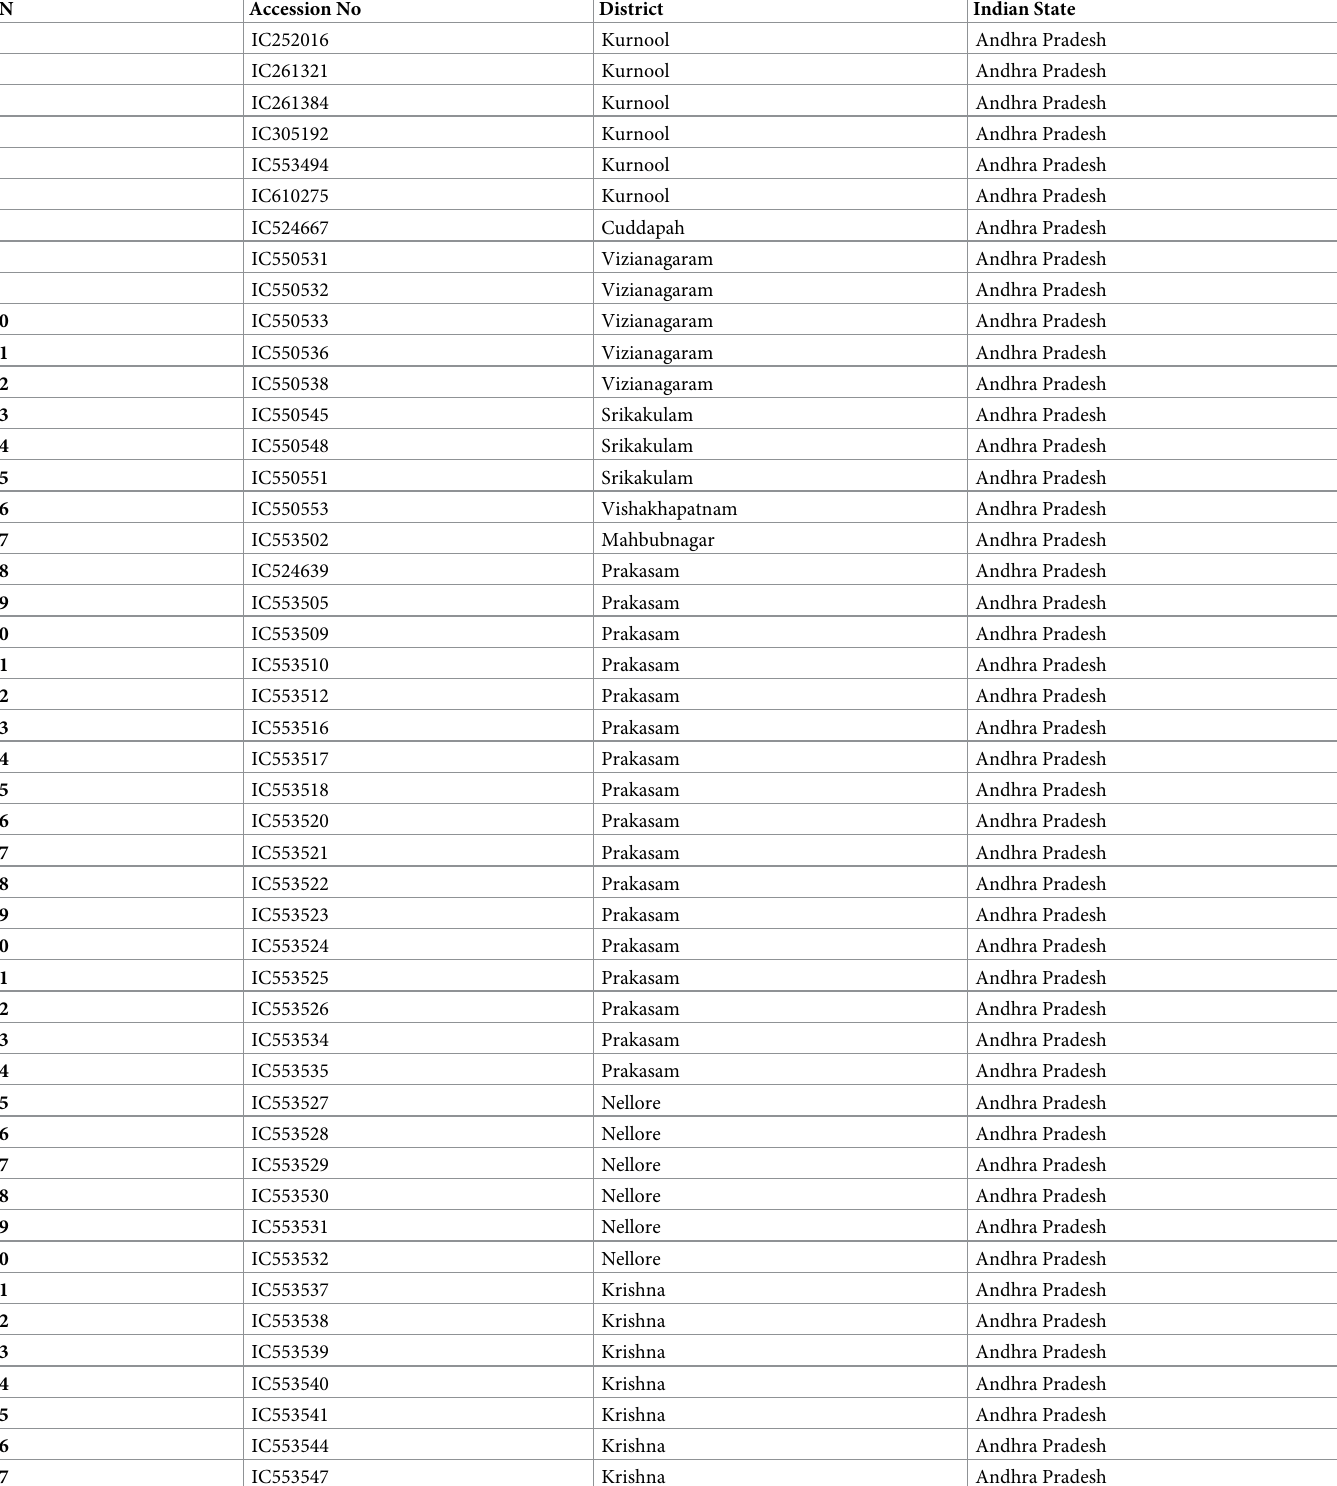
Table 1. Details of passport data of V . stipulacea germplasm used in the